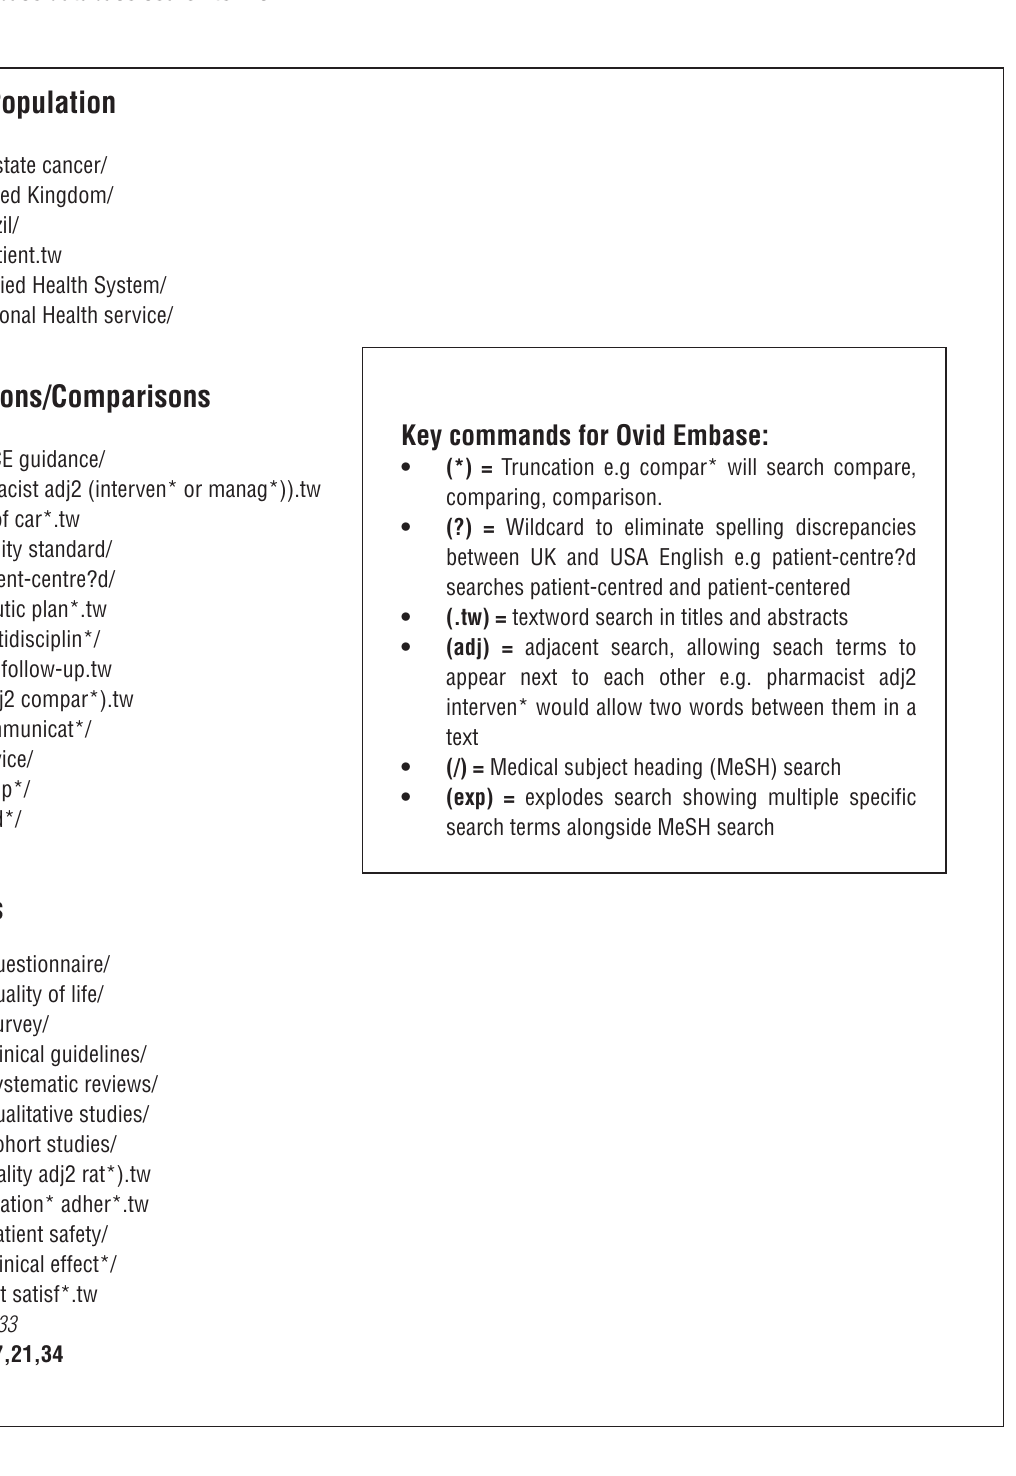
Table 3 – Ovid Embase database search